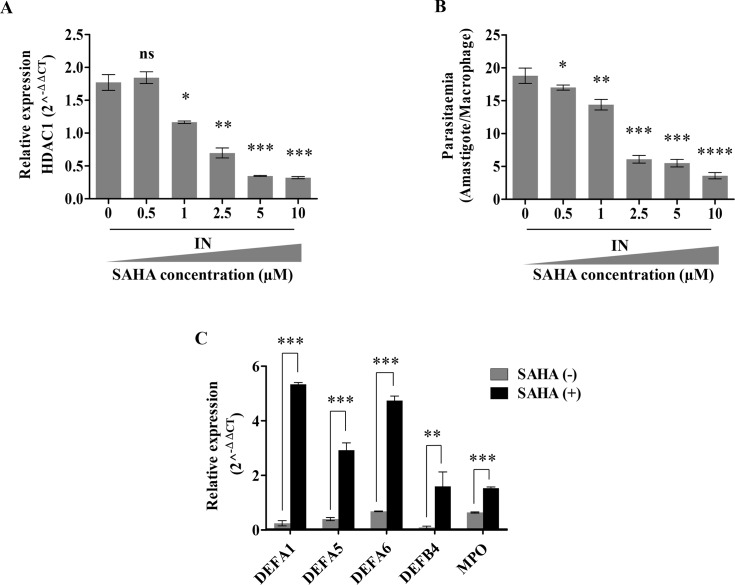
HDAC1 inhibiting drug SAHA impairs parasite survival.THP-1 cells (105 cells/ml) were infected with L. donovani (20:1 MOI) for 3 h.The infected (IN) cells were then incubated with increasing amounts of SAHA and were then harvested at 6 h. A: Expression of HDAC1 infected (IN) THP-1 cells after treatment with different concentrations of SAHA. Significance was measured concerning infected and untreated samples (SAHA concentration– 0 uM). B: Dose-dependent impact of HDAC1 inhibitor, SAHA, on the parasitemia count. Infected THP1 cells (IN) were incubated with increasing concentrations of SAHA for 6 h. Cells were stained after 6 h and amastigotes enumerated visually. C: The expression levels of the host defense genes, 6 h post-infection in the absence and presence of SAHA (5 μM) were quantified by qRT-PCR. Results represent the mean ± SD (n = 3). The statistical significance was determined using ANOVA, ns (P>0.05), * (P≤0.05), ** (P≤0.01), *** (P≤0.001), *** (P≤0.0001) and **** (P≤0.00001).